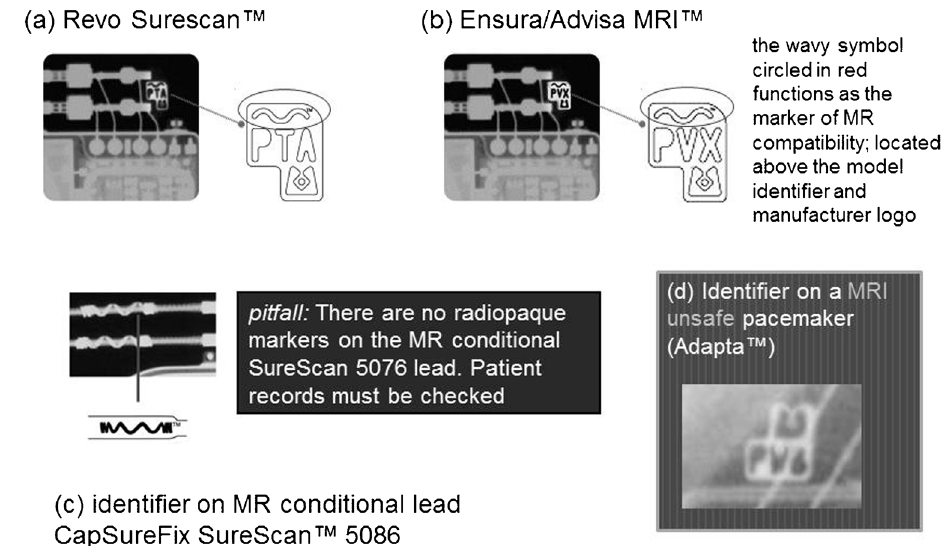
Fig. 7 Magnified radiographic images demonstrate Medtronic manufacturer specific markers (images used with permission). a- b pacemakers which are MR conditional c MR conditional lead